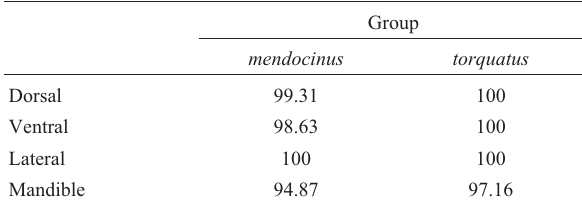
Table 2 - Percentage of correct classification for mendocinus and torquatus groupsusinglineardiscriminantanalysis(LDA)fordorsal,ven- tral, and lateral views of the skull, and lateral view of the